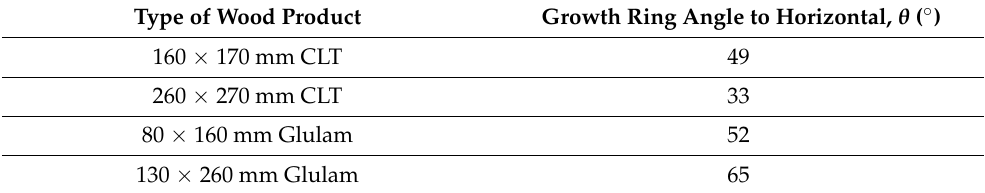
Figure 11. Swelling strain versus moisture content plot for glulam (from Swelling Tests). Table 12. Material orientation angle.